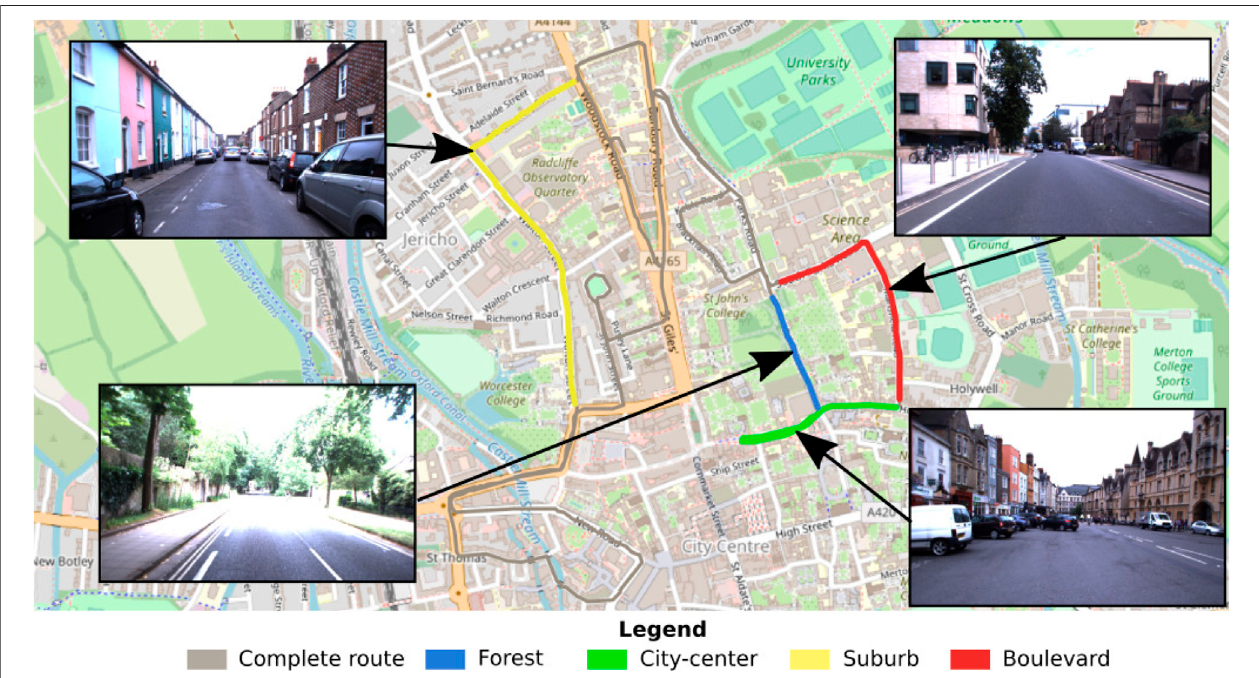
FIGURE 6 | Illustration of the test benchmark dataset. The proposed test benchmark is composed of four kinds of routes covering the following urban environments: suburb , forest , boulevard , and city center . These routes were selected from the entire Oxford car dataset to perform a comparison of the performance of visual place recognition (VPR) models according to the